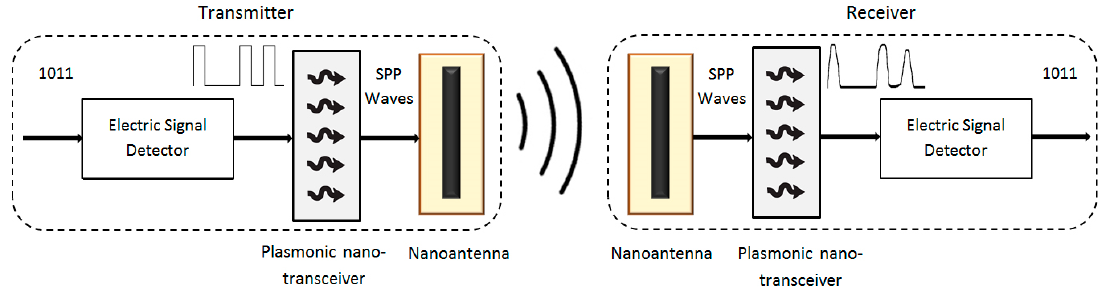
Figure 4. Radiocommunication scheme, transmitter and receiver endpoints.